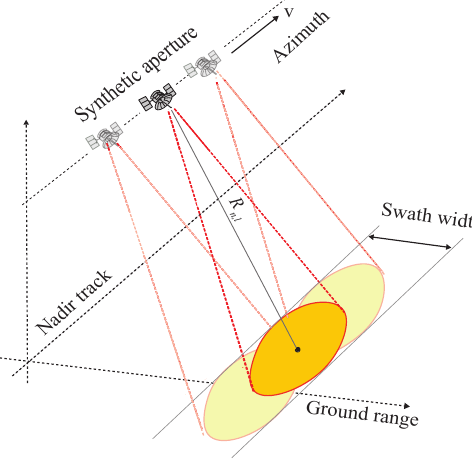
Figure 2. Illustration of stripmap SAR imaging